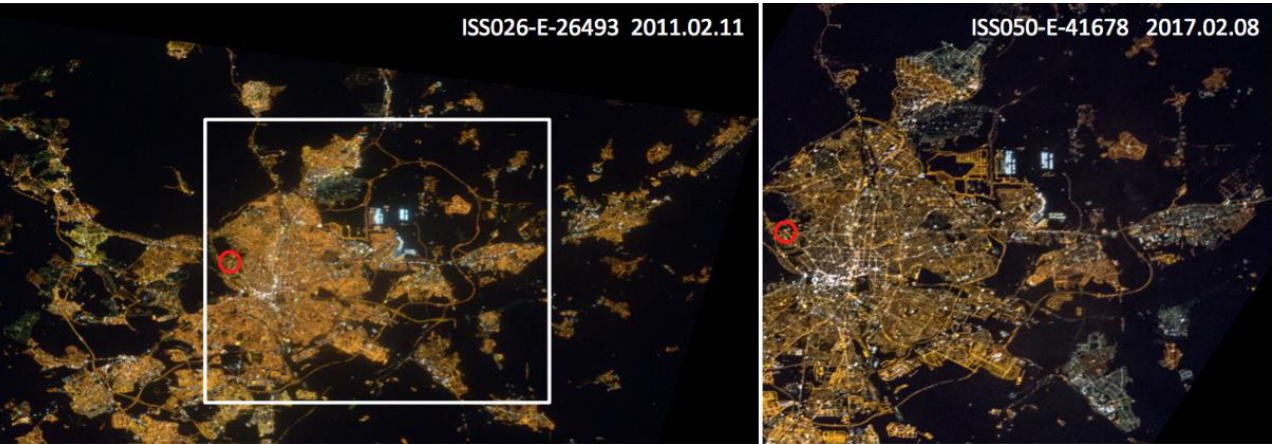
Figure 1. Images of Madrid at night taken from International Space Station (ISS) in 2011 ( left ) and 2017 ( right ). The area marked in white on the 2011 image is reproduced with greater detail in the 2017 image. The red circle marks the position of the Astronomical Observatory of Universidad Complutense de Madrid. Images from NASA Gateway to Astronaut Photography of Earth [24] https://citiesatnight.org/ (accessed on 9 April 2021).